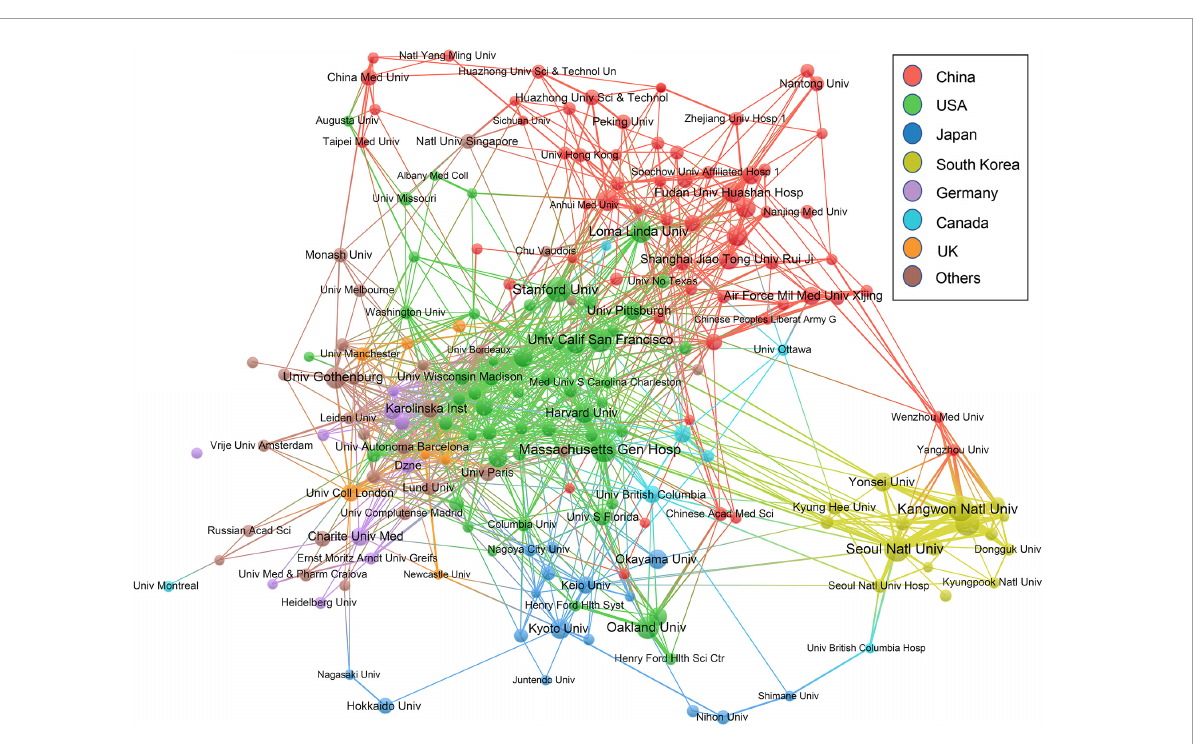
FIGURE4 Collaboration networks of the institutions with ten or more